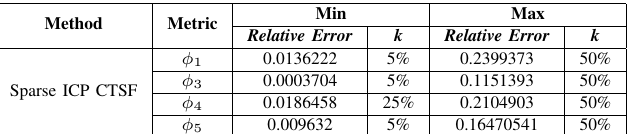
TABLE III: Sparse ICP CTSF rotation relative error for 90 ◦ alignment 45 ◦ −